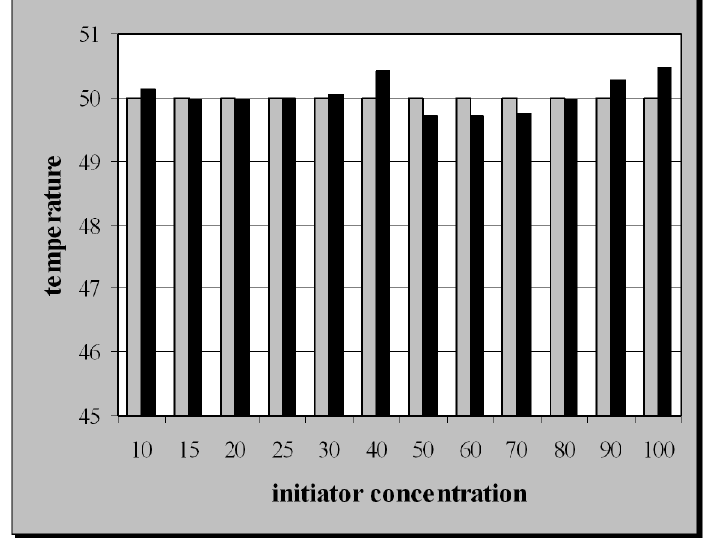
Fig. 19 Temperature values obtained with MLP (2:12:4:2) in INN modeling for a simulated temperature of 50 o C at di¬erent initiator concentration, I 0 = 10 ¥ 100 mol/m 3 ; gray bars - simulation training data; black bars - results of the inverse neural model.